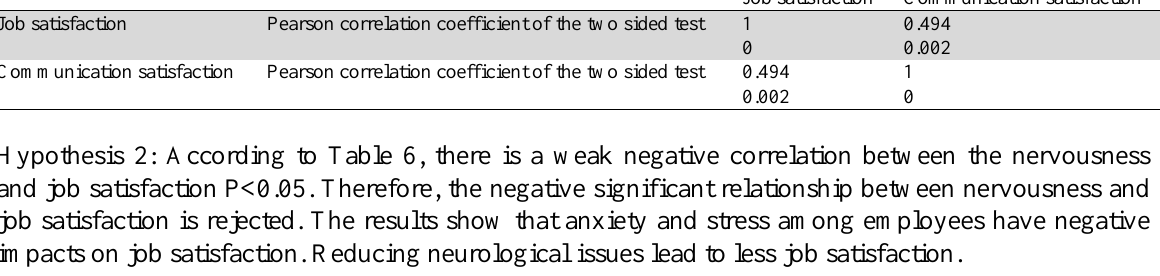
Job satisfaction Communication satisfaction